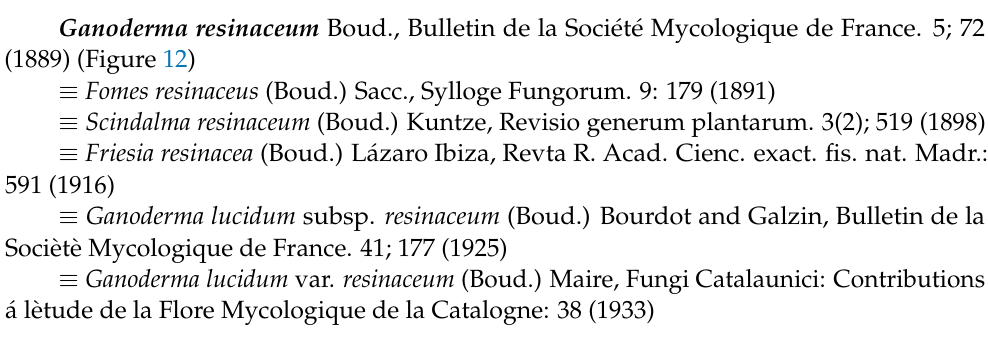
Figure 11. Morphology of Ganoderma multiplicatum (MFLU 19 ‐ 2152): ( a ) mature basidiomes; ( b ) pore characteristics; ( c ) hyphae of tube layers in KOH; ( d – f ) context hyphae in KOH; ( g – i ) basidiospores. Scale bars: ( a ) = 2 cm, ( b ) = 1000 μ m, ( d – f ) = 20 μ m, ( g – i ) = 5 μ m.